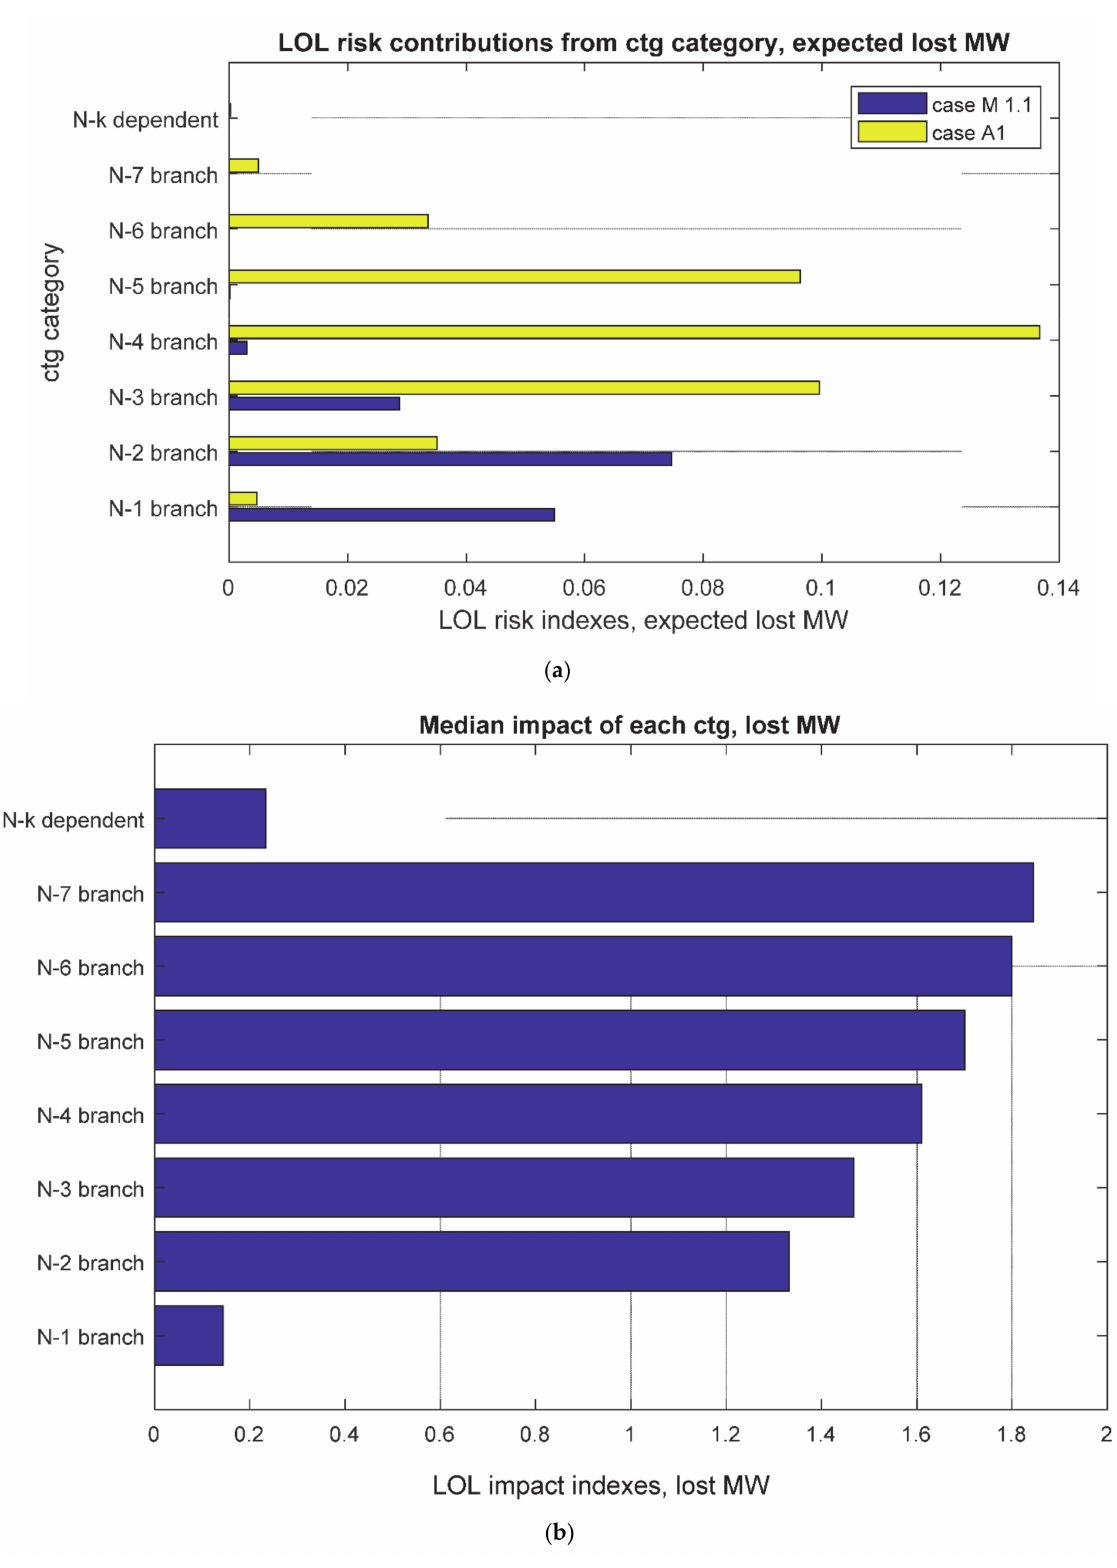
Figure 7. Risk analysis results for case M1.1: ( a ) contributions of different contingency orders to the LOL risk with respect to base case A1, ( b ) median impact per contingency